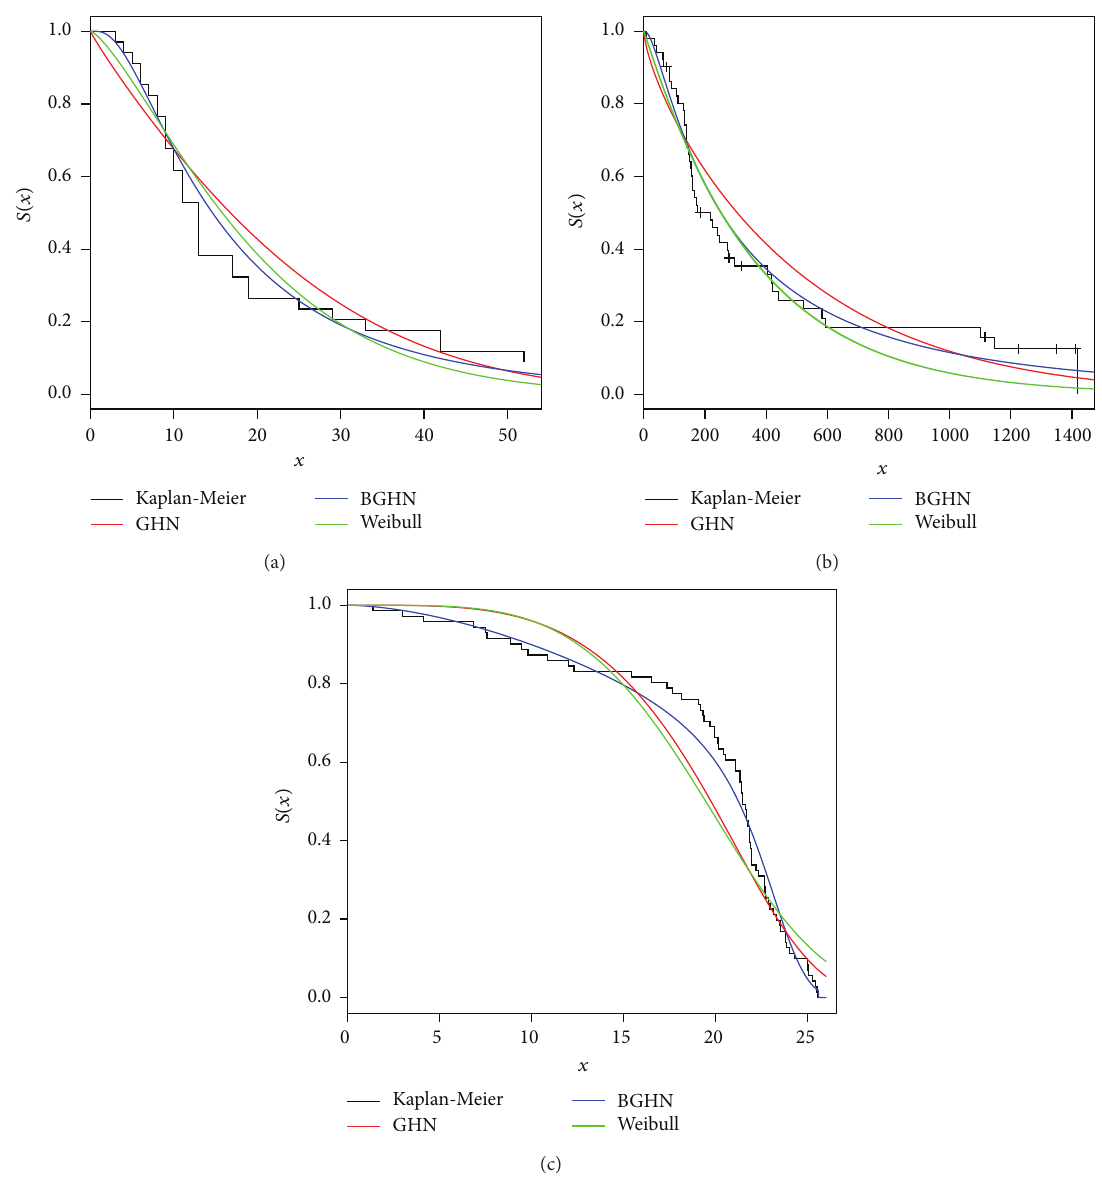
Figure 1: Estimated survival function for the BGHN, GHN, and Weibull distributions and the empirical survival; (a) for transistors data, (b) for radiotherapy data, and (c) USS Halfbeak diesel engine data.